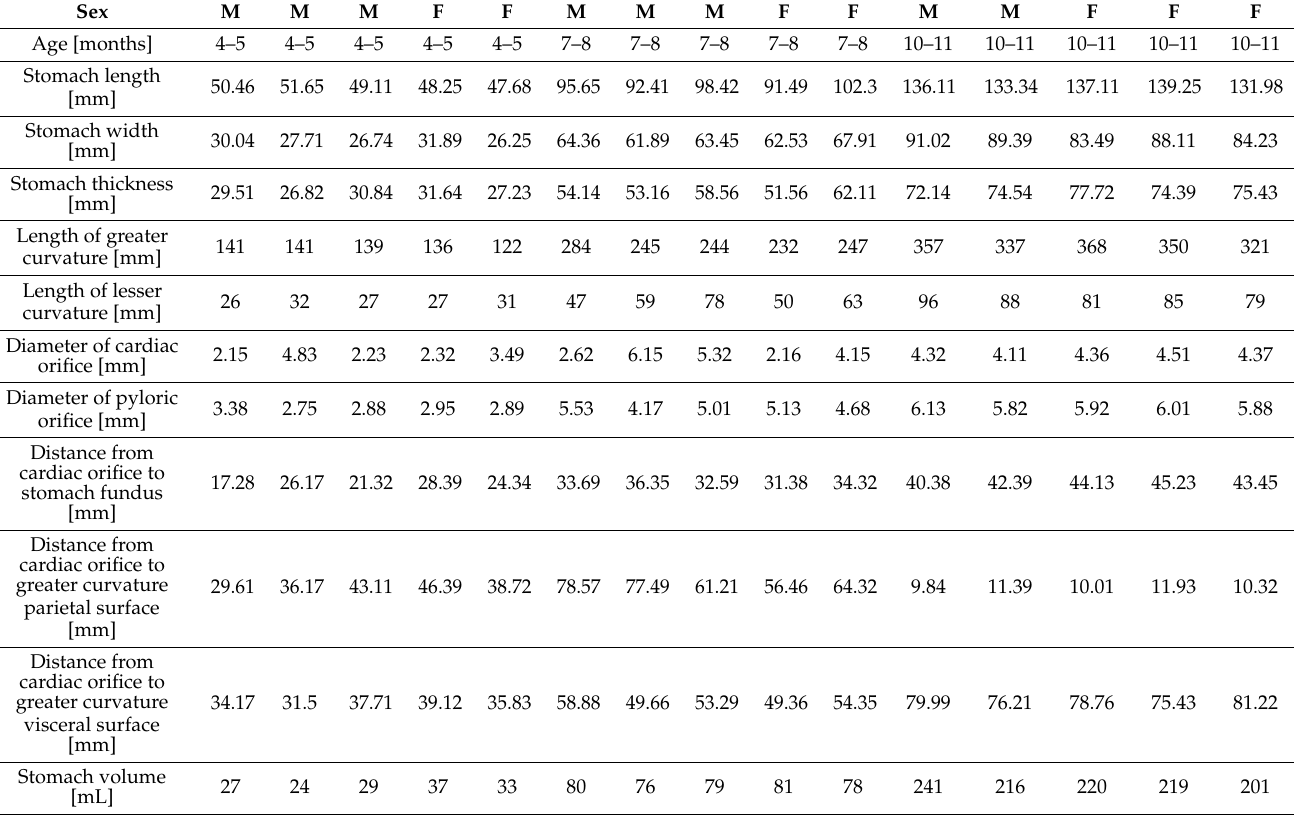
Table 2. Morphometry of the horse stomach.